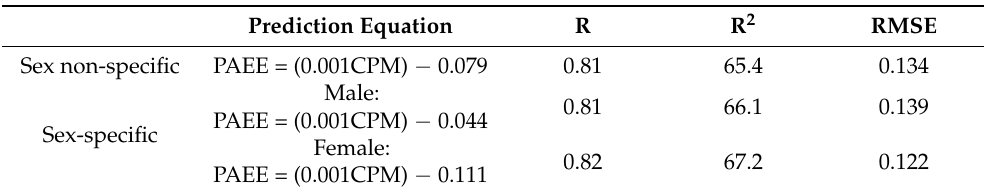
Table 2. Preliminary sex non-specific and sex-specific equations for prediction of PAEE (kcal/min) from the validation group ( n = 54).